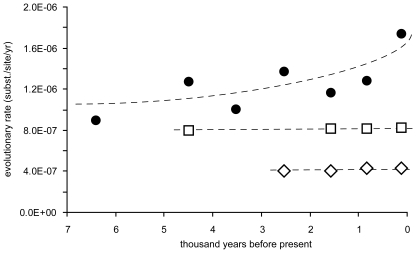
Accelerated rate of evolution in M. graminicola.
Estimates of evolutionary rates for Mycosphaerella graminicola and its two closest relatives “S1 and “S2” (see Figure 2) under a relaxed clock model. Mean rates for internal branches of the β-xylosidase-based phylogeny are shown as filled circles for M. graminicola, squares for the lineage “S2”, and diamonds for the lineage “S1”, respectively.